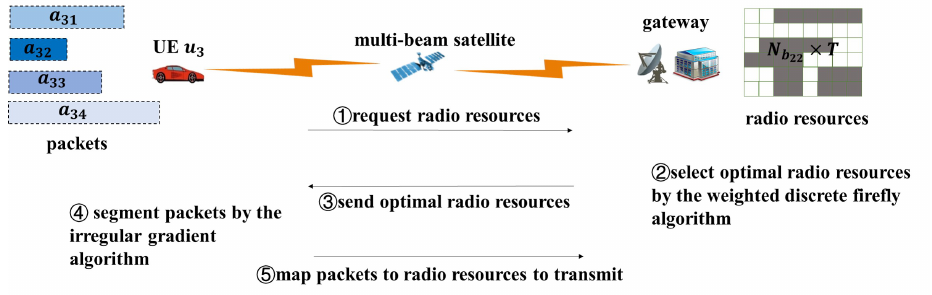
Figure 2. Packet transmission